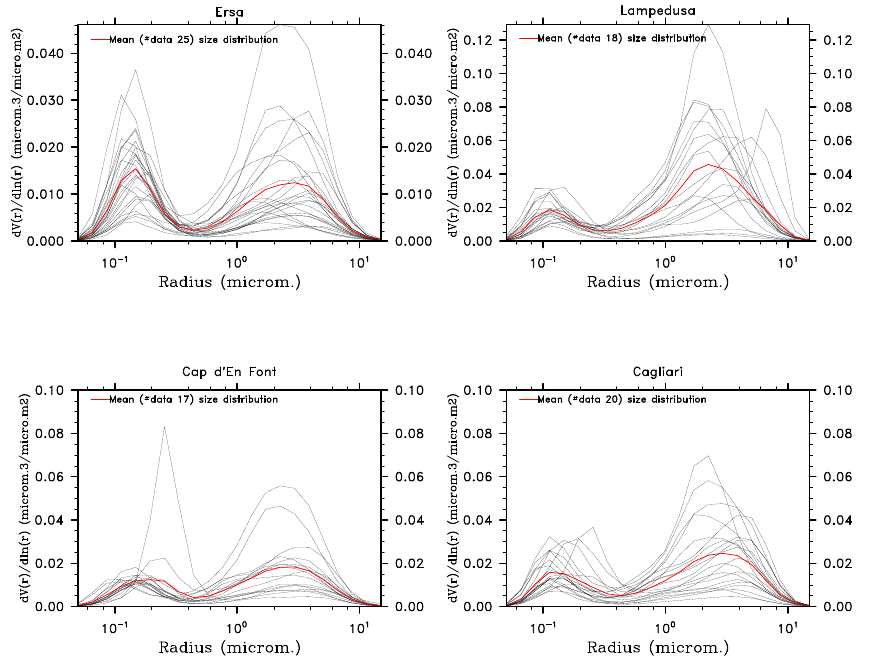
Figure 14. AERONET/PHOTONS volume size distribution derived at four different stations: Ersa, Lampedusa, Cagliari and Cap d’En Font (the red curve represents the mean of observations). The characteristics of the volume size distribution are provided in Table